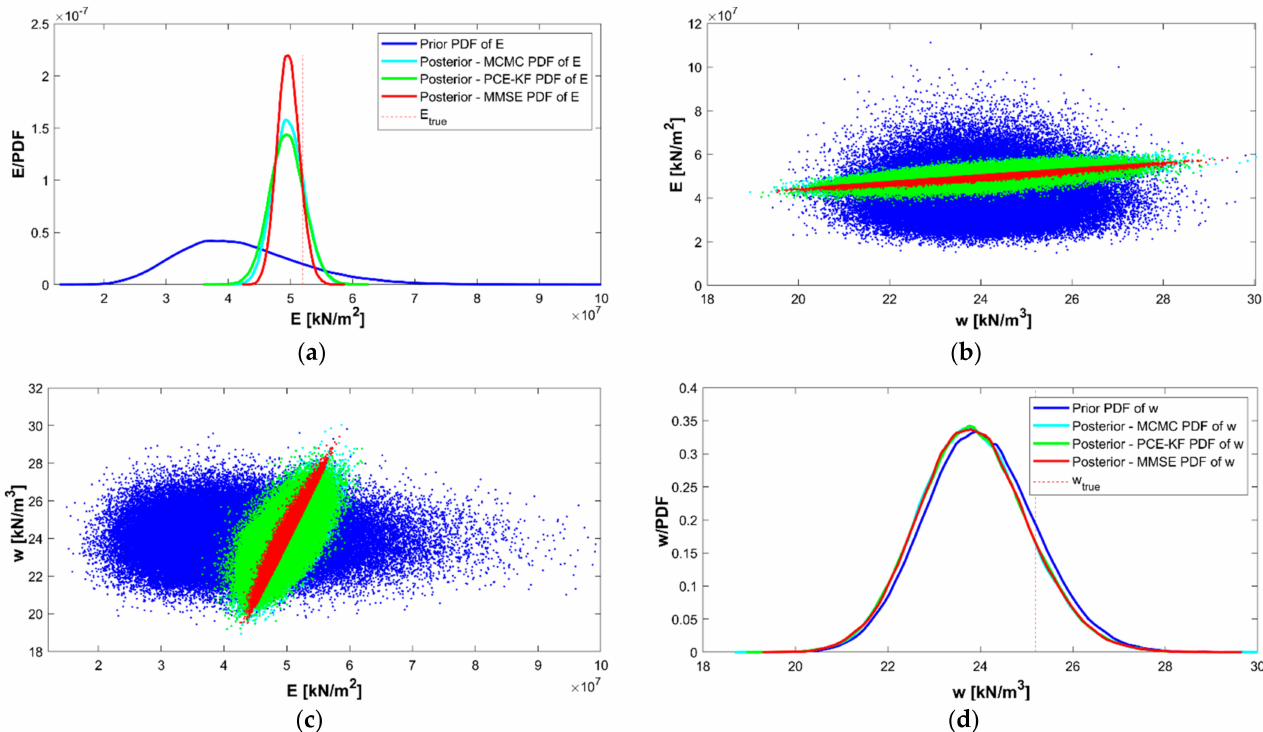
Figure 18. Comparison of different updating methods with two uncertain parameters—concrete water tank: ( a ) prior and marginal posterior pdfs of EJ , ( b ) scatterplot of the samples of the prior and posterior pdfs , ( c ) prior and marginal posterior pdfs of m and ( d ) scatterplot of the samples of the prior and posterior pdfs. The prior distributions and the results of the different methods are shown with different colors: prior (in blue), MCMC (in cyan), PCE-KF (in green) and MMSE (in